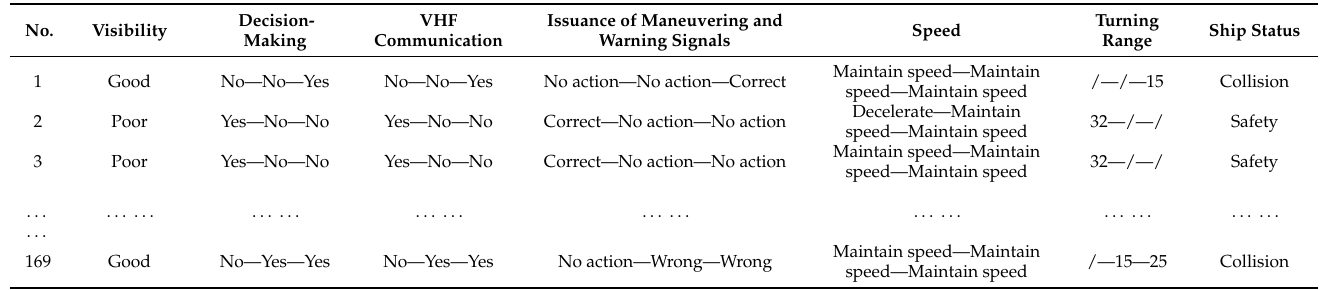
Table 4. Crew behavior when preventing collisions on a navigation simulator during the ship encounter phase.